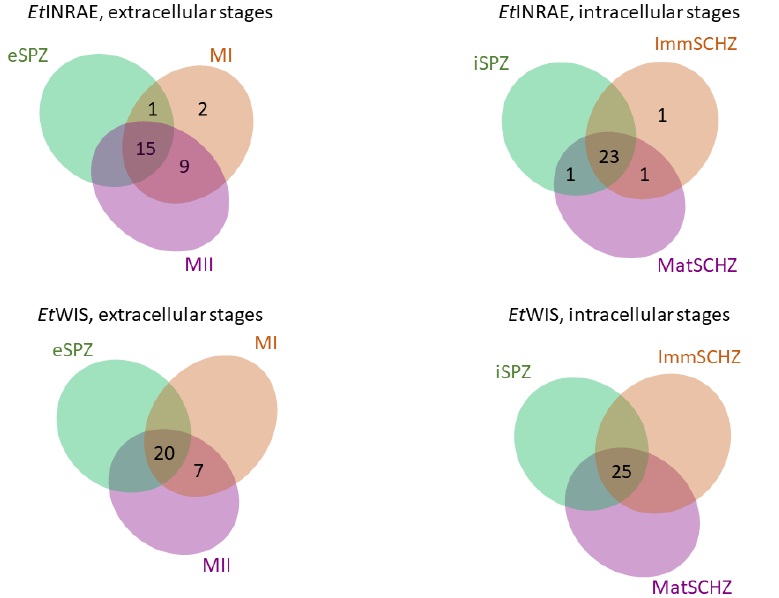
Figure 8. Venn diagram of differentially transcribed rhoptry kinases in three extracellular stages and three intracellular stages of the Et INRAE and Et WIS strains. eSPZ extracellular sporozoites, iSPZ intracellular sporozoites, ImmSCHZ immature schizonts, MatSCHZ mature schizonts, MI first-ge-neration merozoites, and MII second-generation merozoites. In extracellular stages, 27 ropks were transcribed, in intracellular stages, 26 and 25 ropks were transcribed in Et INRAE and Et WIS, respectively.